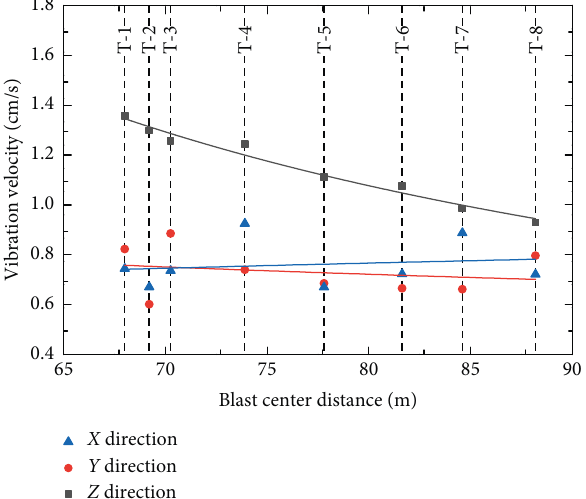
Figure 6: Relationship between the vibration velocity and the blast center distance of the upper step.